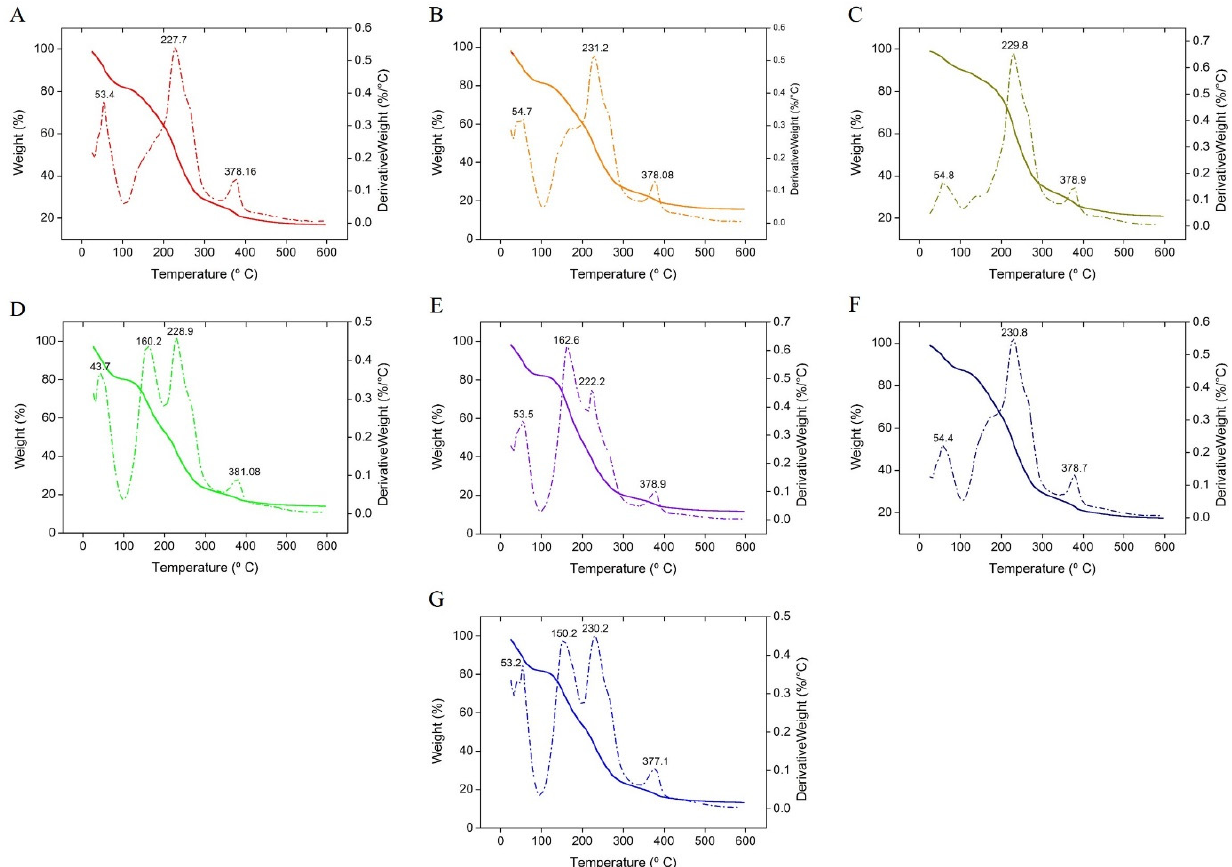
Figure 9. TGA and DTG signals of heat pressed films ( A – G ).